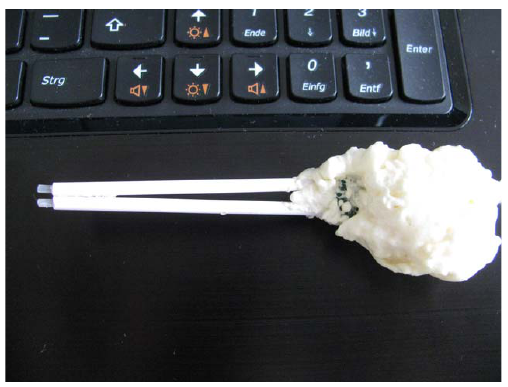
Fig. 2. Thermocouple design with foam coat for thermal insulation of the cold